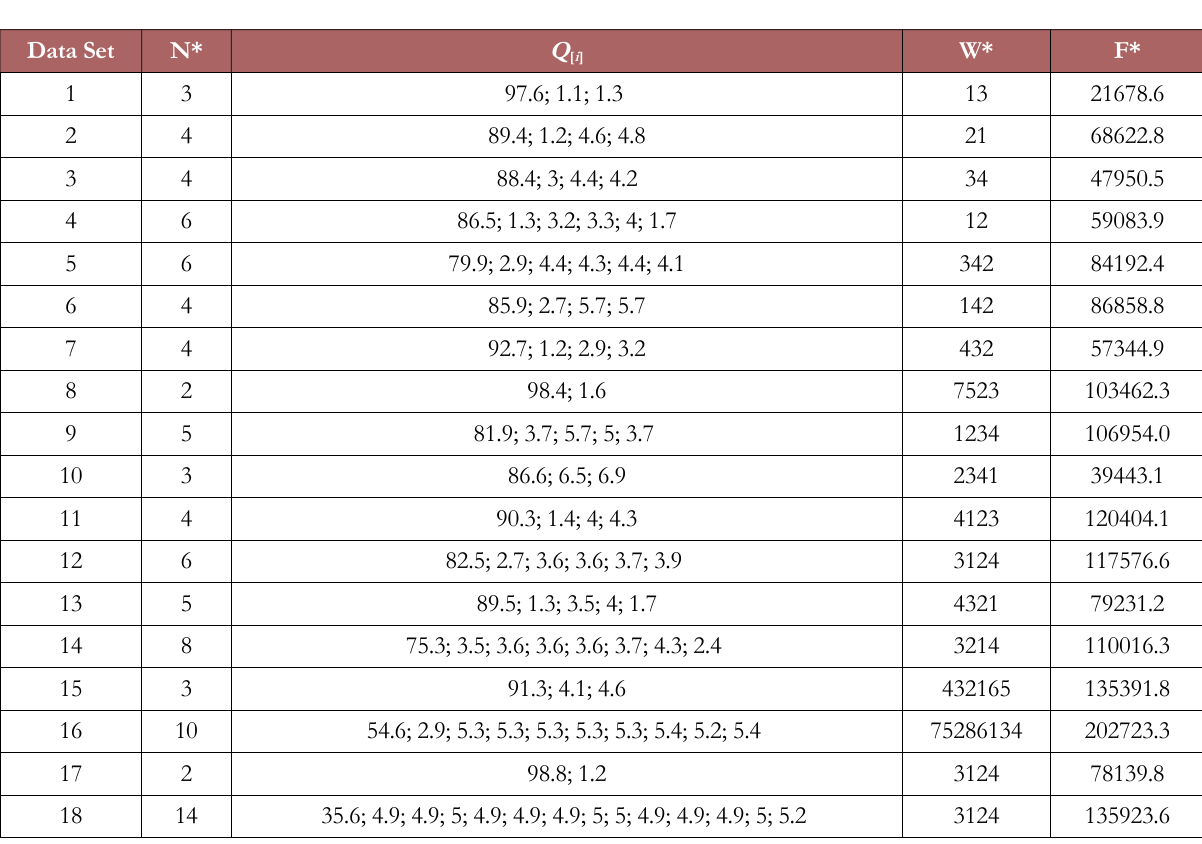
Table 2. Computation results